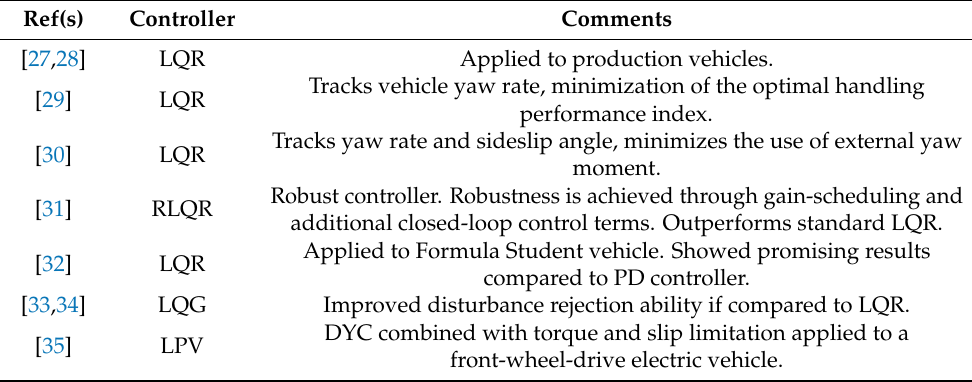
Table 3. Optimal controllers applied to